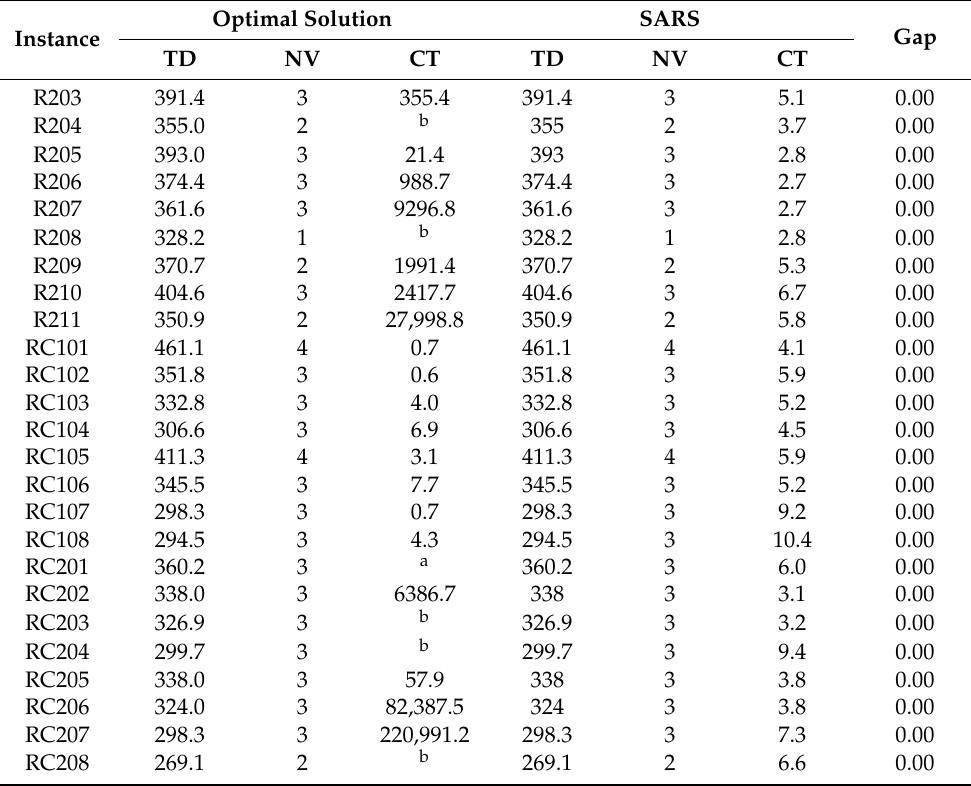
Table 6. Comparison of SARS with other heuristics in the currently published papers on the VRPTW dataset with 100 customers (average best solution for each instance).